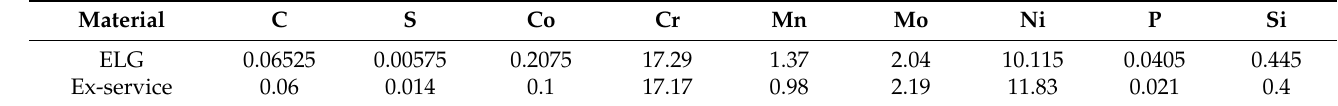
Table 1. Chemical composition of ELG and ex-service material (wt%). Both materials are different casts of 316H austenitic stainless steel.